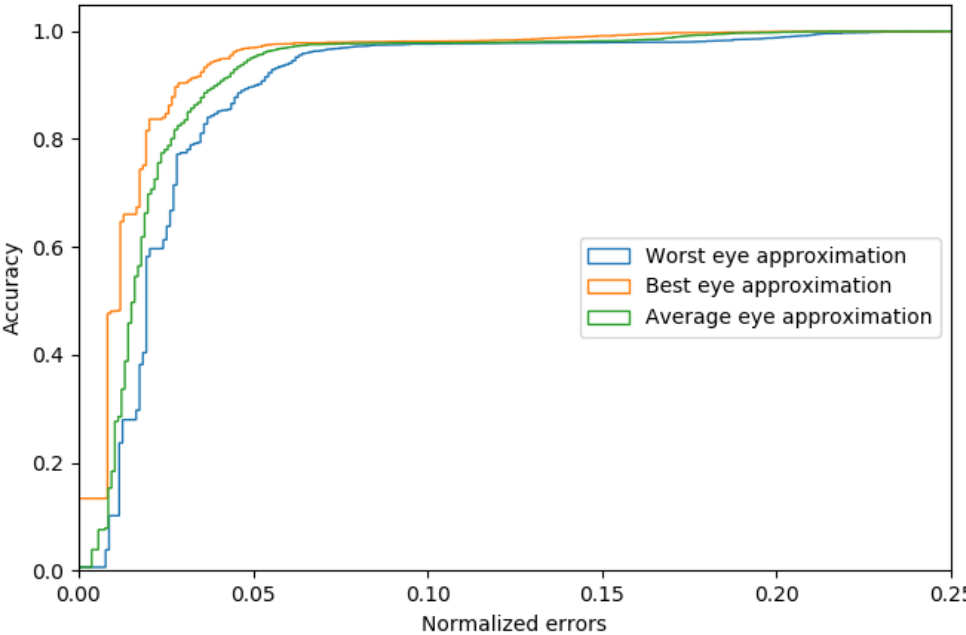
Figure 8. Cumulative error distribution on the Talking Face database.